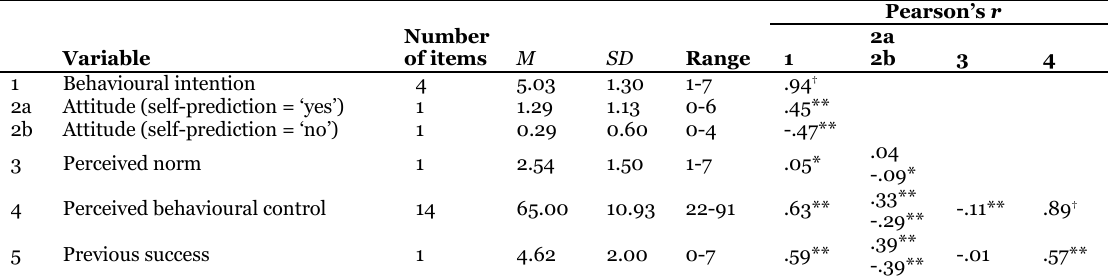
Table 2 list for each variable the mean (M) and standard deviation ( SD ) as well as the correlations between these variables. Table 2 Descriptive Data of the Used Variables (N =